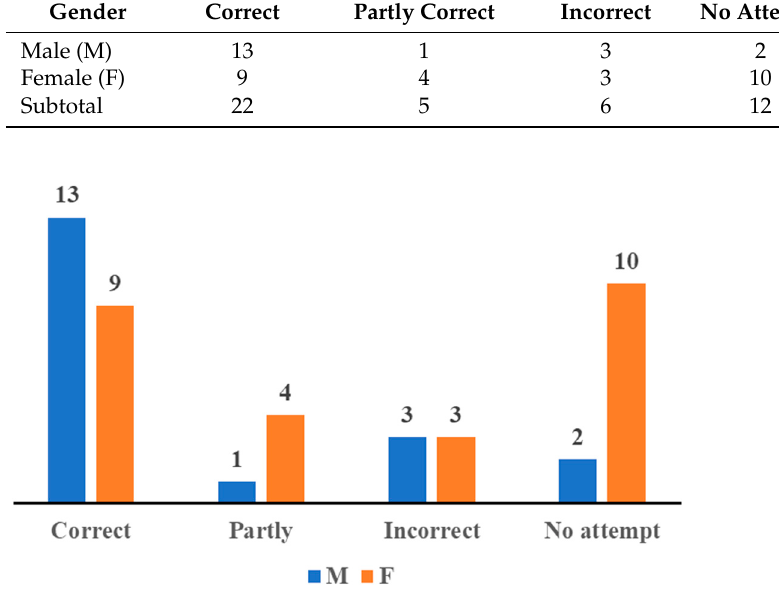
Figure 8. Frequency distribution of student’s results and actions by gender groups. Table 12. Results of chi-test on student’s results and actions from the two gender